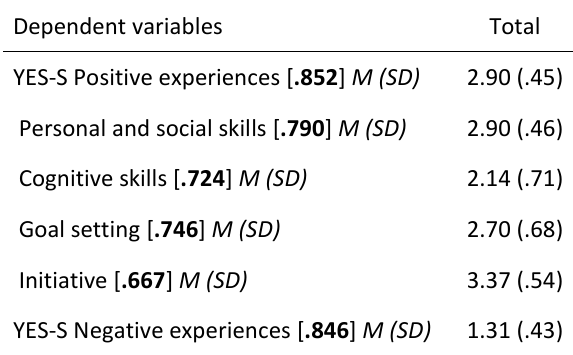
Table 2. Descriptive statistics for dependent variables (means with standard deviations and reliability